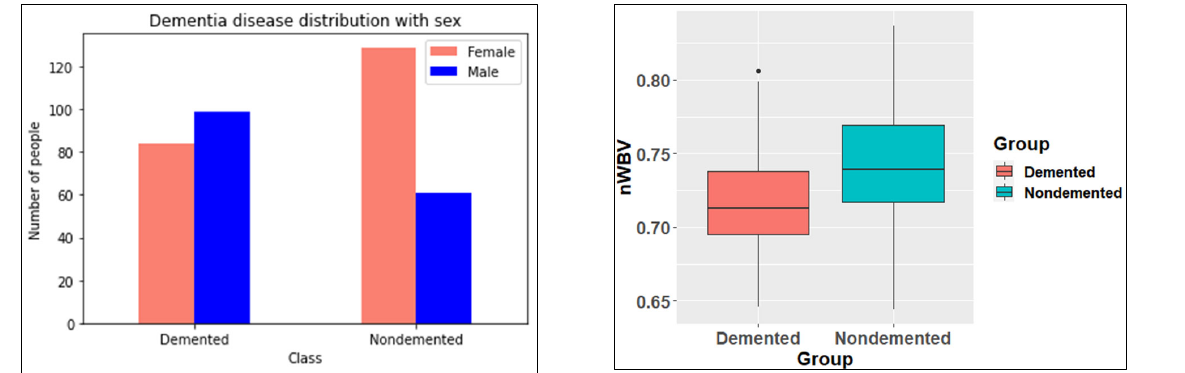
Fig. 1. Dementia disease distribution with gender among study participants